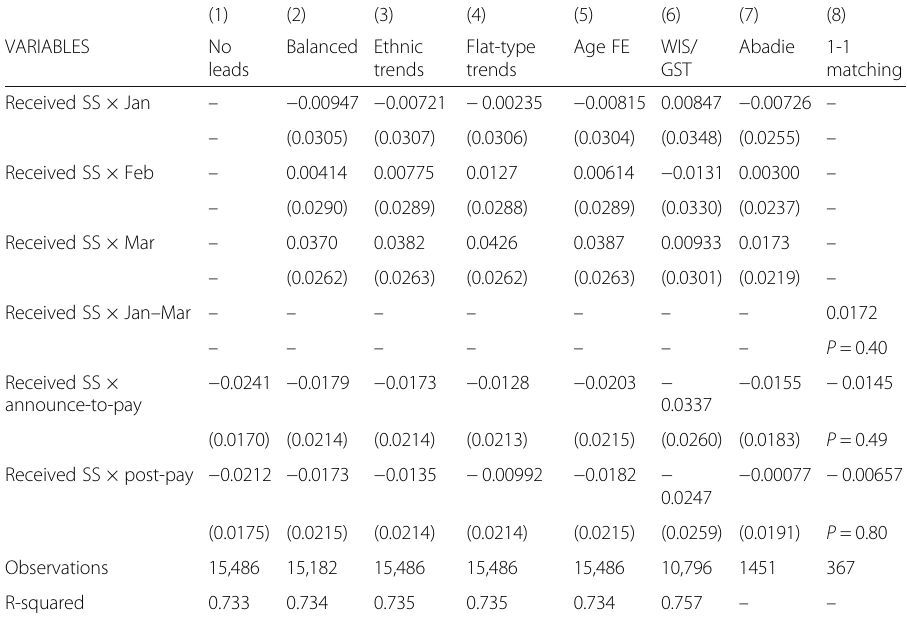
Table 17 Robustness check for impact of receiving SSS payouts on receiving private cash